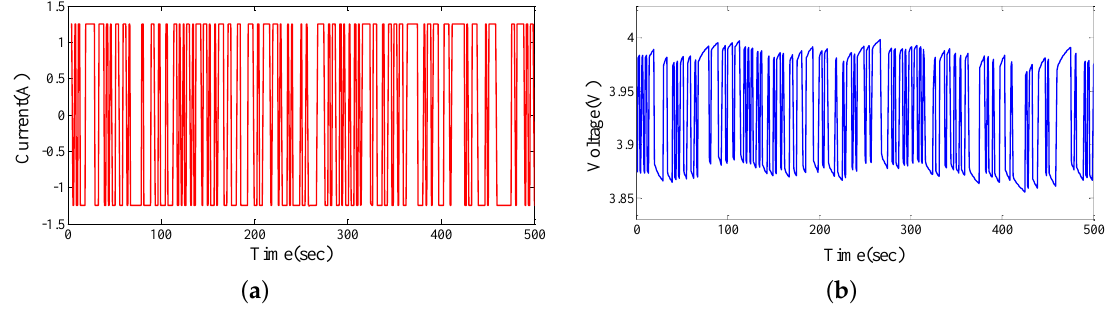
Figure 6. PRBS excitation signal test at 25 ◦ C. ( a ) PRBS test current waveform at 70% SOC. ( b ) PRBS test voltage response waveform at 70%